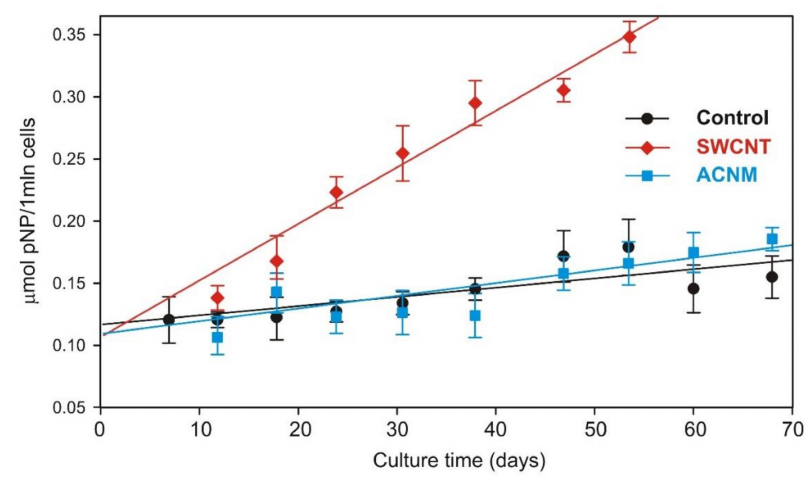
Figure 5. Senescence-associated β -galactosidase activity assay during long-term exposure of mesenchymal stem cells. Bars represent mean ± SD.